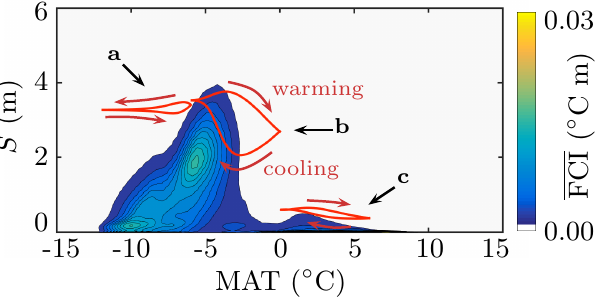
Figure 7. Evolution of mean sediment thickness (red curves) on the three summit flats shown in Fig. 6. Rates of frost cracking as function of MAT and sediment thickness are shown as background contours. Letters a, b, and c refer to the summit flats shown in Fig. 6. Note that in all three cases mean sediment thickness varies in a cyclic manner when MAT increases and decreases over each cli- mate cycle. The cold and the intermediate models have much thicker sediments ( ∼ 3m) than the warm model ( ∼ 0 . 5m). The intermedi- ate model shows the strongest thickening and thinning of the sedi- ment cover because the MAT varies between the two zones of most effective frost cracking and most effective frost